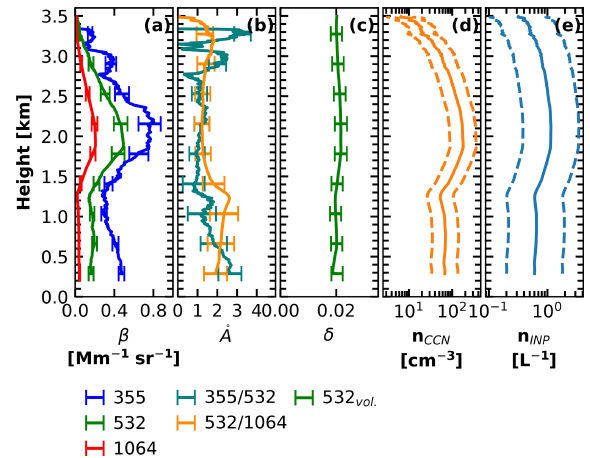
Figure 13. Averaged aerosol optical properties for the time pe- riod from 00:00 to 02:20UTC on 10 June 2017 up to 3.5km height. (a) Aerosol backscatter coefficient for three wavelengths of 355nm (blue), 532nm (green), and 1064nm (red). (b) Backscatter- related Ångstrom exponent for 355 to 532nm (cyan) and for 532 to 1064nm (orange). (c) The 532nm volume depolarization ratio. In panel (d) the retrieved CCN number concentration for C 2 = 10cm − 3 and d 2 = 0 . 9 and in panel (e) the INP number concen- tration for T = − 15 ◦ C are shown together with the respective un- certainty (dashed lines) derived from the 532nm backscatter coeffi- cient profile shown in panel (a) .